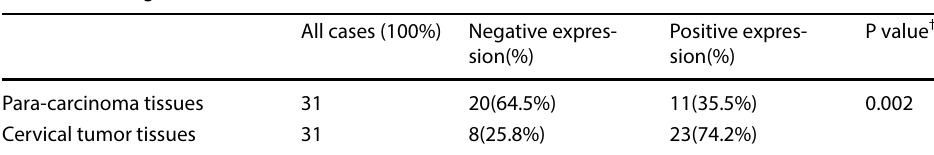
testTMEM40 staining